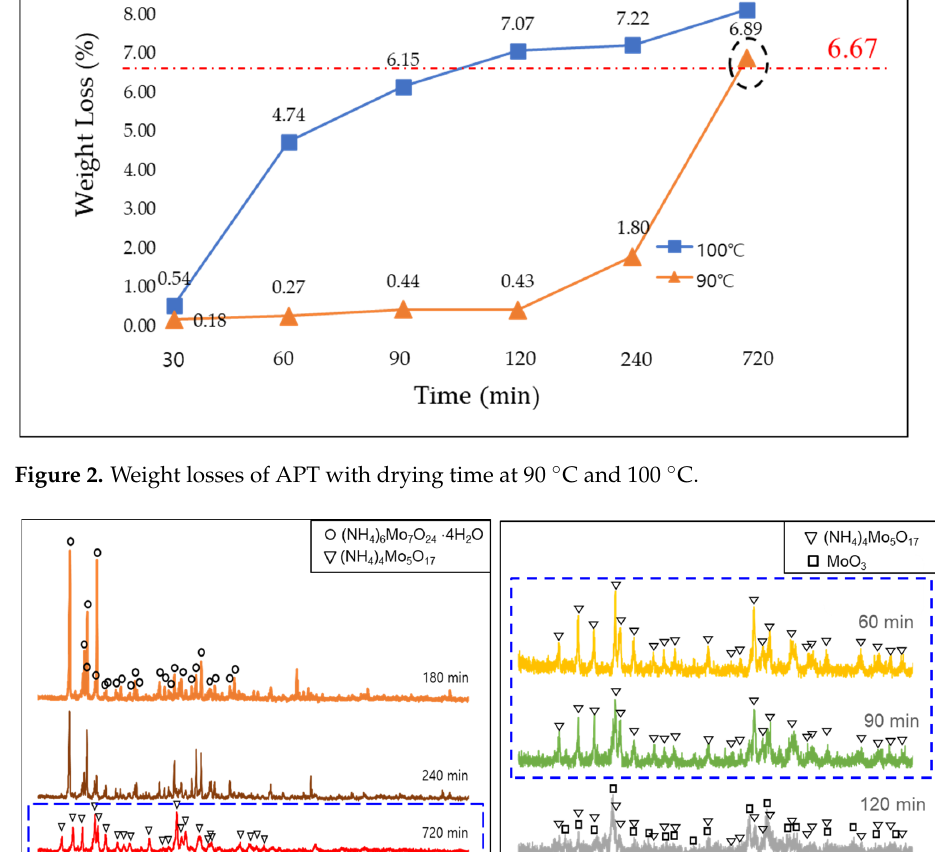
Figure 4. SEM images of ammonium molybdates before and after drying (at 90 °C for 720 min). 3.1.2. Self-Reduction of (NH 4 ) 4 Mo 5 O 17 After the transformation of (NH 4 ) 6 Mo 7 O 24 ·4H 2 O into (NH 4 ) 4 Mo 5 O 17 , the contents of residual ammonia and hydrogen, which can be utilized as reductants, in the ammonium molybdate increased, as shown in Table 1. The reactions related to this utilization can be listed as follows: